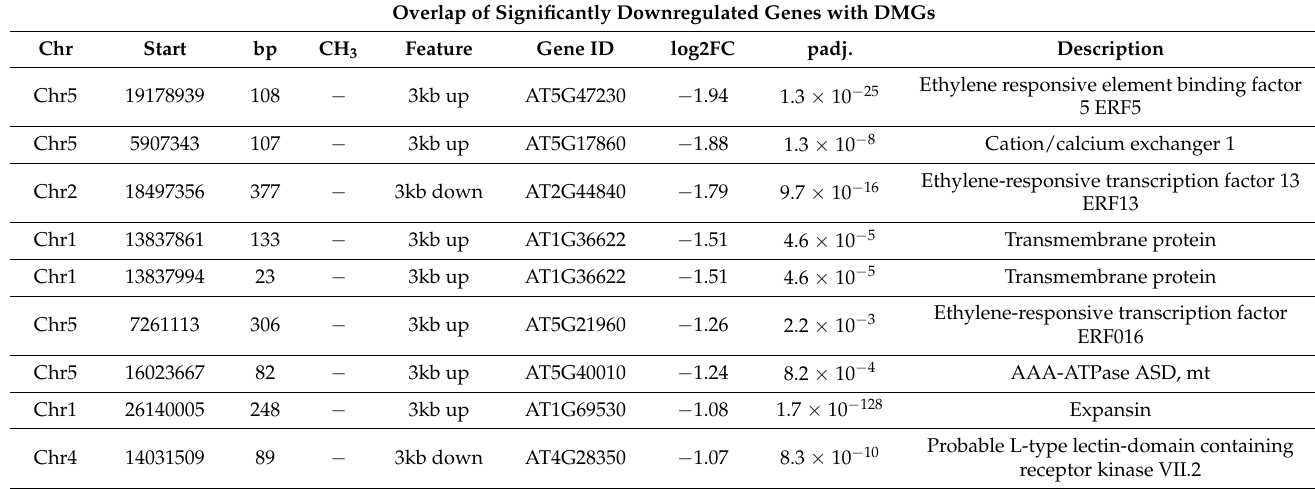
Table 4. Integrative analysis of DMGs and DEGs in sahh1